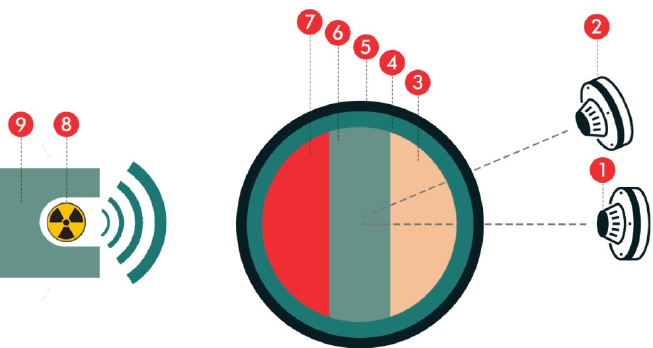
Figure 1. The structure of the simulated detection system. 1: first detector 2: second detector 3: Gas phase 4: scale 5: tested pipe 6: oil phase 7: water phase 8: gamma Source 9: source shield.